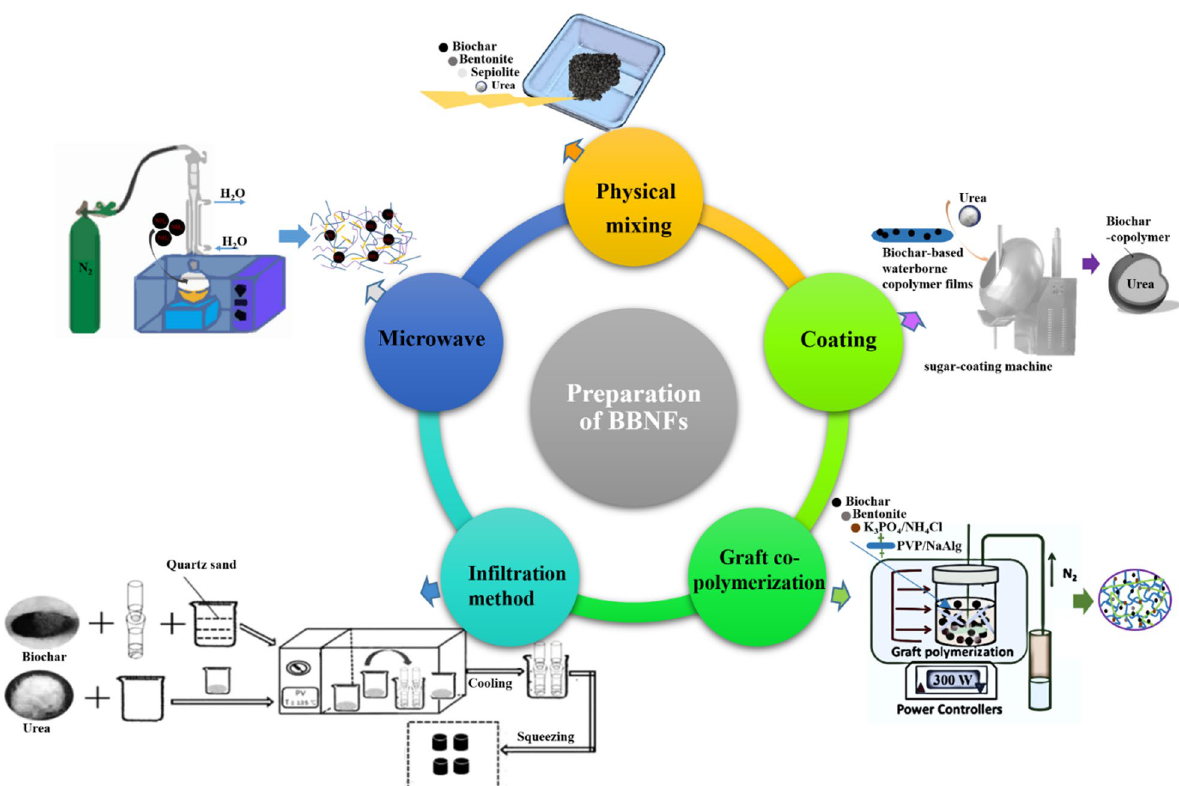
Fig. 1 Schematic showing methods used for preparations of